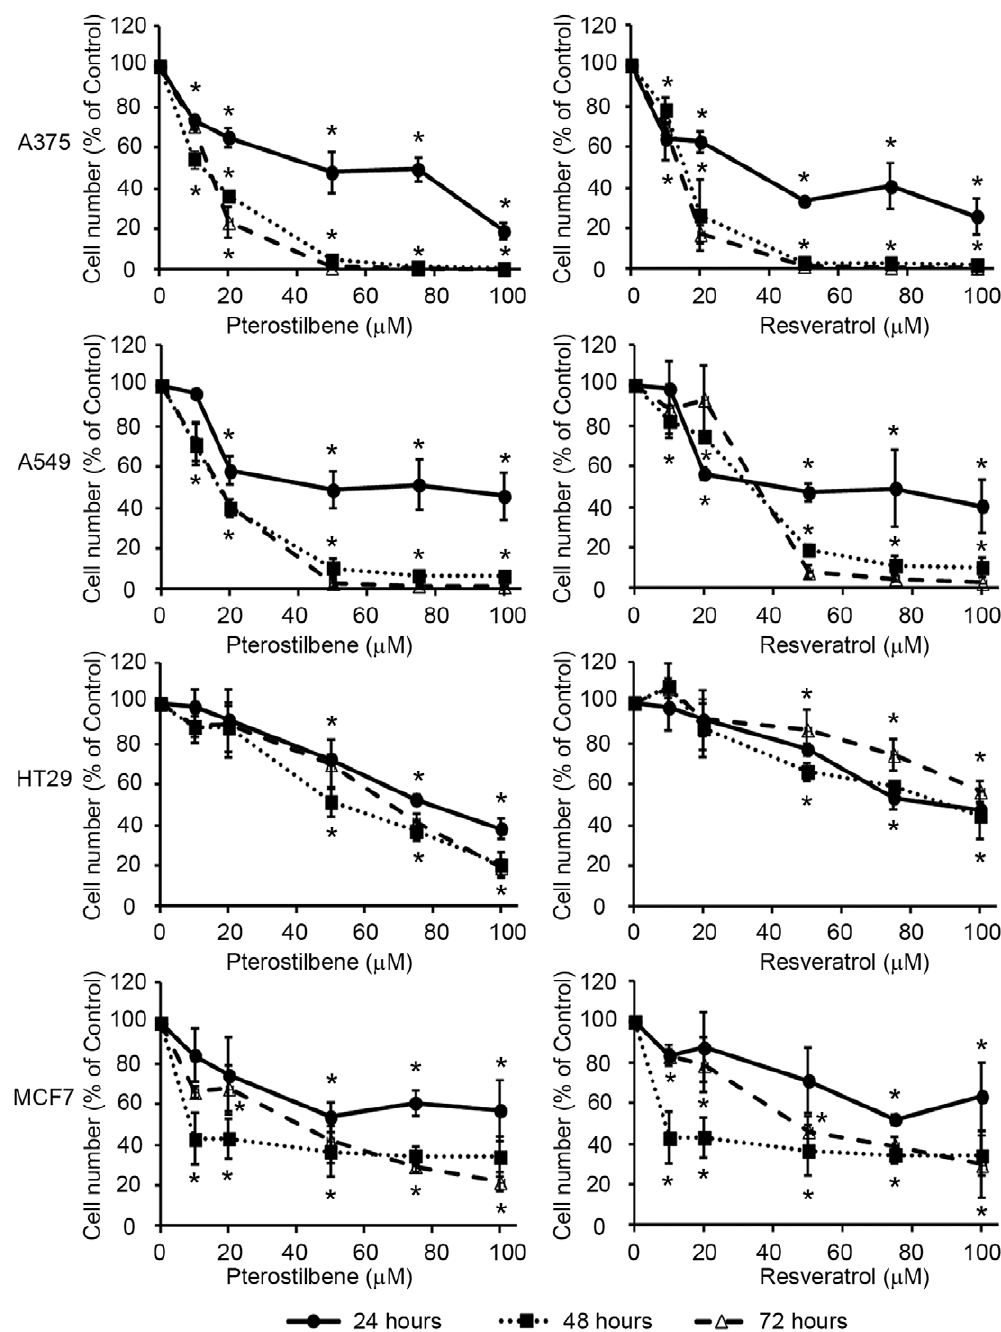
Figure 1. Effect of pterostilbene and resveratrol on tumor cell growth invitro . A375, A549, HT29 and MCF7 cells were incubated for 24, 48 or 72 h with indicated concentrations of Pter or Res. Actual cell number was analyzed using the Countess Automated Cell Counter. Results were expressed as relative proliferation index 6 SD (n=4) where control is 100% (*P , 0.05). doi:10.1371/journal.pone.0044524.g001 (marker of apoptosis) only in A375 and A549 cells (Figure 3B). To evaluate the contribution of apoptosis on cell death induction we used a cell-permeable pan-caspase inhibitor z-VADfmk. Notably, z-VAD-fmk failed to inhibit the Pter-induced reduction in cell number (Figure 3C). Positive controls of apoptosis and zVADfmk S1). These results suggest that caspase-independent mechanisms